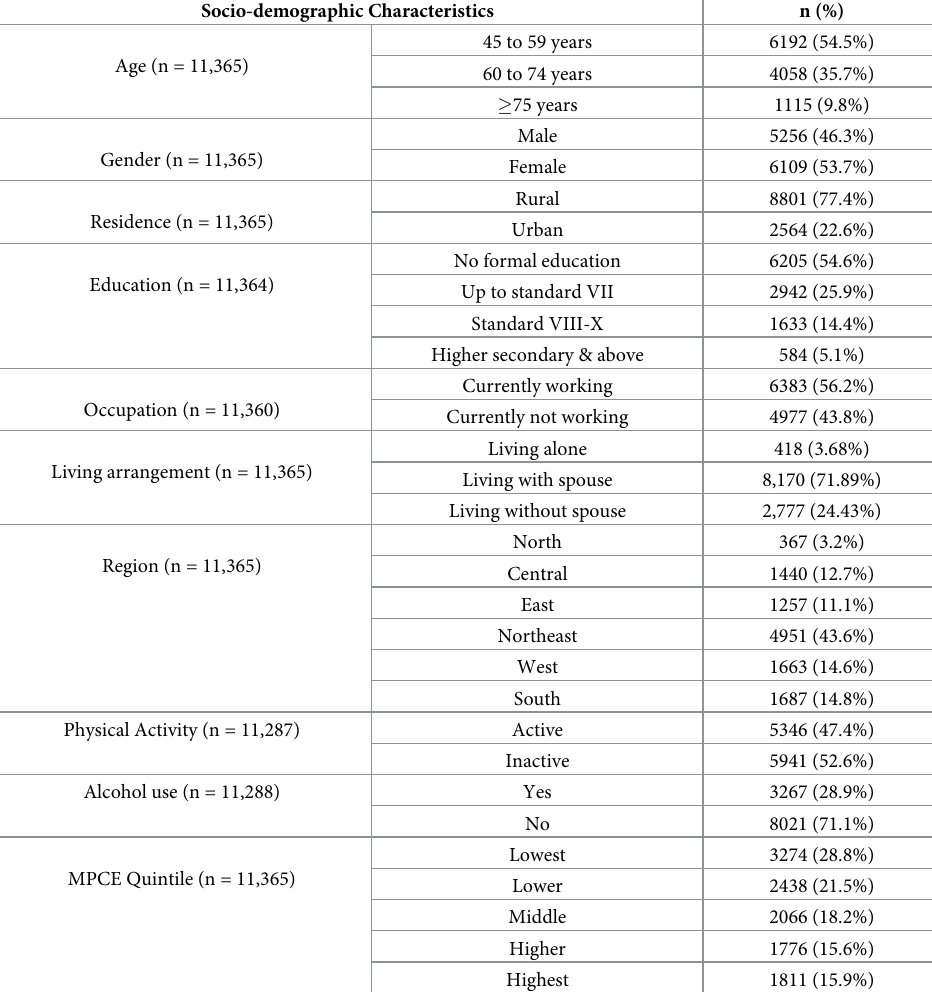
Table 1. Sociodemographic characteristics of study population (n =